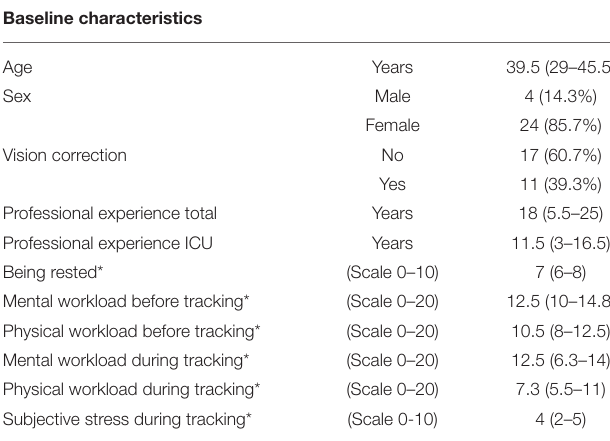
TABLE 1 | Baseline characteristics of